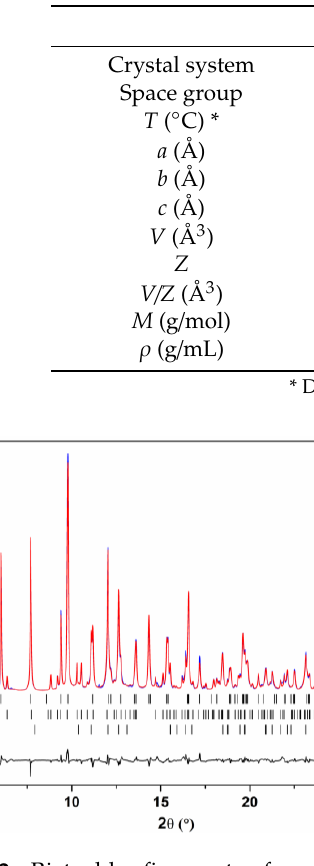
Figure 2. Rietveld refinements of synchrotron radiation powder X-ray di ff raction (SR-PXD) data measured with λ = 0.7129 Å, showing experimental (blue line) and calculated (red line) PXD patterns, and a di ff erence plot below (black line). ( a ) Ba(BH 4 ) 2 · 2NH 3 is measured at T = − 25 ◦